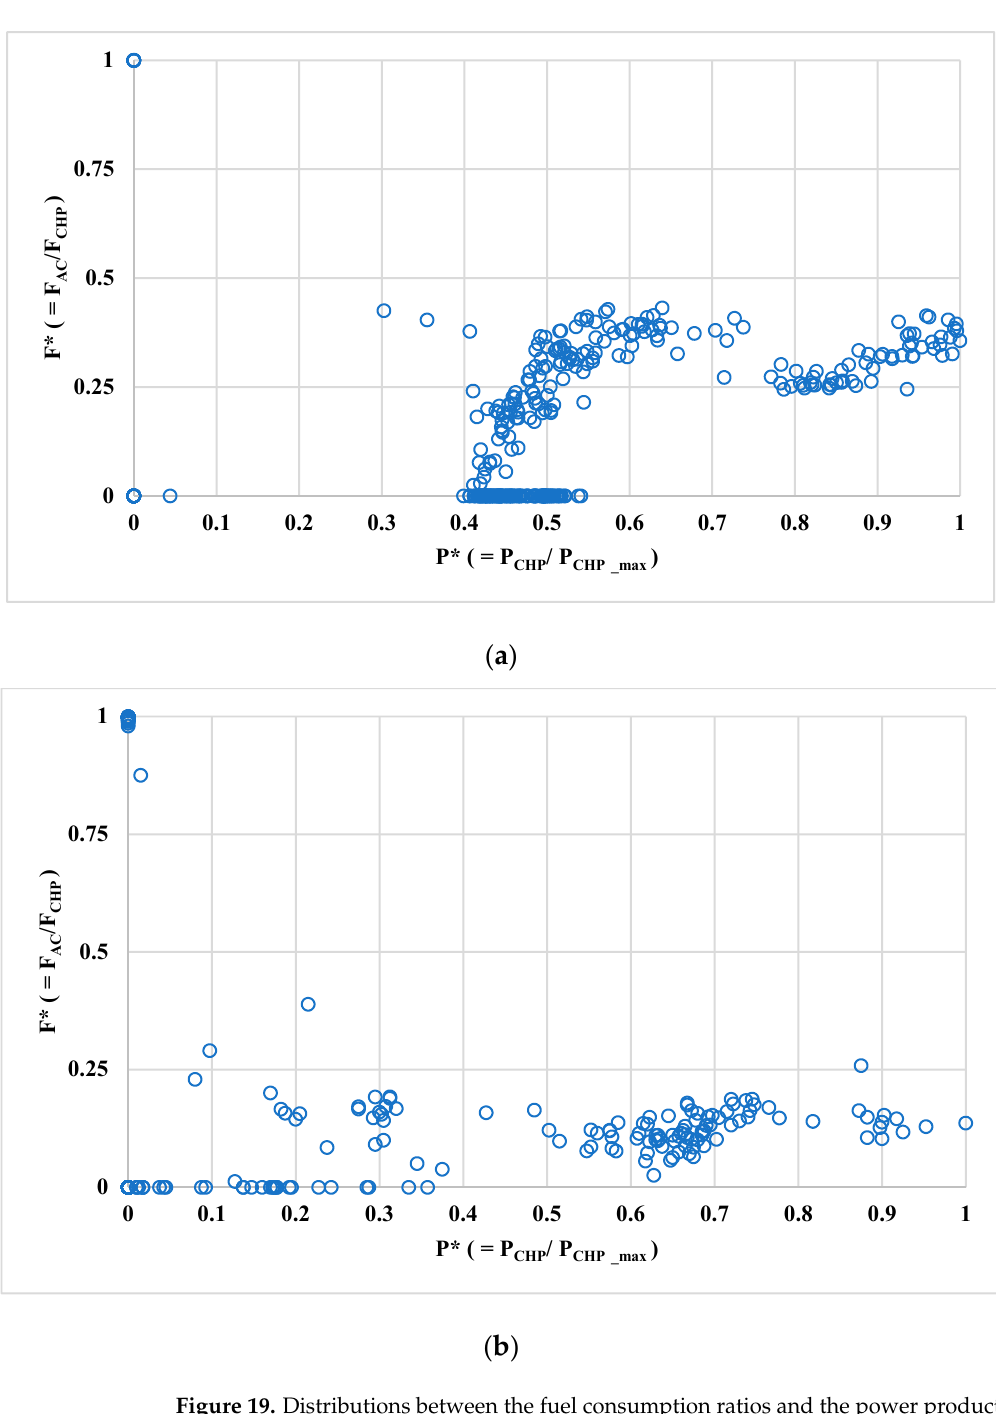
Figure 19. Distributions between the fuel consumption ratios and the power productions for Cases A and B. ( a ) Case A. ( b ) Case B.